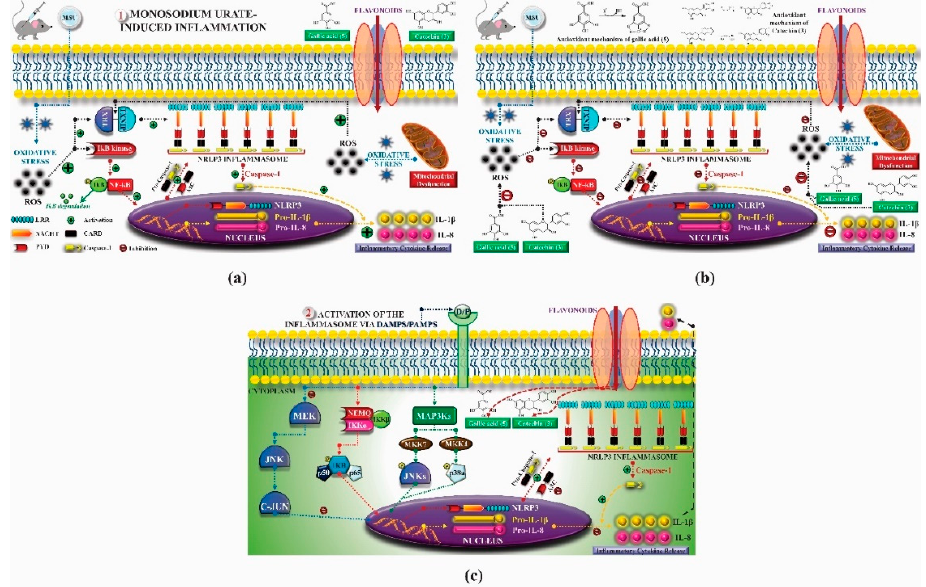
Figure 1. Molecular mechanism of flavonoids in inflammasome regulation: ( a ) Studies suggest that oxidative stress is an important mediator of monosodiumurate (MSU) induced inflammation [51]. The formation of reactive oxygen species (ROS) induces nuclear translocation of Nuclear Factor-kappa B (NF-kB) via phosphorylation by IkB kinase, which binds to target DNA that regulates Pro-IL-1 β and Pro-IL-8 gene expression. In addition, ROS dissociates the thioredoxin (TRX) and thioredoxin interaction protein (TXNIP) conjugation [52], and released TXNIP further recruits and binds to NLRP3 inflammasome, leading to the release of IL-1 β [53] and IL-8. NLRP3 inflammasome consists of NLRP3, caspase recruitment domain (ASC), and pro-caspase-1. Mitochondrial ROS (MtROS) is also associated with NLRP3 inflammasome activation [53]. In the process of NLRP3 inflammasome activation, activated caspase-1 transforms pro-IL-1b and pro-IL-18 into mature IL-1b and IL-18, resulting in the release of inflammatory cytokines; ( b ) Flavonoid uptake occurs either via passive diffusion through the cell membrane, or through membrane bound transport proteins. Cut circles indicate different points of flavonoid action, inhibiting the process of inflammasome formation with subsequent inhibition of inflammatory events [54]. Phenolic compounds block the inflammatory process by inhibiting ROS formation, thereby reducing the formation of pro-inflammatory cytokines. The nature and position of substituents in relation to the hydroxyl group affect the activity of polyphenols. The easily ionizable carboxylic group contributes to the efficient hydrogen donation tendency of phenolic acids [55]. Gallic acid has high antioxidant activity rate. This is due to a beneficial influence of carboxylate on the antioxidant activity of phenolic acids [56]. The tricyclic structure of flavonoids, such as catechin, determines their antioxidant effect. Phenolic quinoid tautomerism and the localization of electrons over the aromatic system eliminate reactive oxygen species. These aromatic rings directly neutralize free radicals and increase antioxidant defense [57]; ( c ) DAMPs / PAMPs bind to their receptor on the cell membrane and activate a signaling cascade. As a consequence, activation and formation of NRLP3 inflammasome occur, where the formation of active caspase-1 catalyzes the cleavage and secretion of mature IL-1 β and IL-18, leading to propagate inflammation [54]. ASC, caspase recruitment domain; C-JUN / JNK, c-Jun N-terminal Kinase; CARD, caspase recruitment domain; DAMPs, damage-associated molecular patterns; I κ B, inhibitor of κ B; IKK α , IkBkinase α ; IKK β , IkBkinase β ; IL-1 β , Interleukin 1-beta; IL-8, Interleukin 8; LRR, leucine-rich repeats; MAP3Ks, mitogen-activated protein 3 kinases; MEK, mitogen-activated protein kinase; MKK4, mitogen-activated protein kinasekinase 4; MKK7, mitogen-activated protein kinase kinase 7; MtROS, Mitochondrial ROS; MSU, monosodiumurate; NACHT, central nucleotide-binding and oligomerization domain; NEMO, NF-kappa-B essential modulator; NF-KB, Nuclear Factor-kappa B; p38a, p38 kinase α ; p50, NF-KB, Nuclear Factor-kappa B 1 (NF-KB1); p65, RelA; PAMPs, pathogen-associated molecular patterns; PYD, pyrin domain; ROS, reactive oxygen species; TXNIP, thioredoxin interaction protein; TRX, thioredoxin; TXNIP, thioredoxin interaction protein.